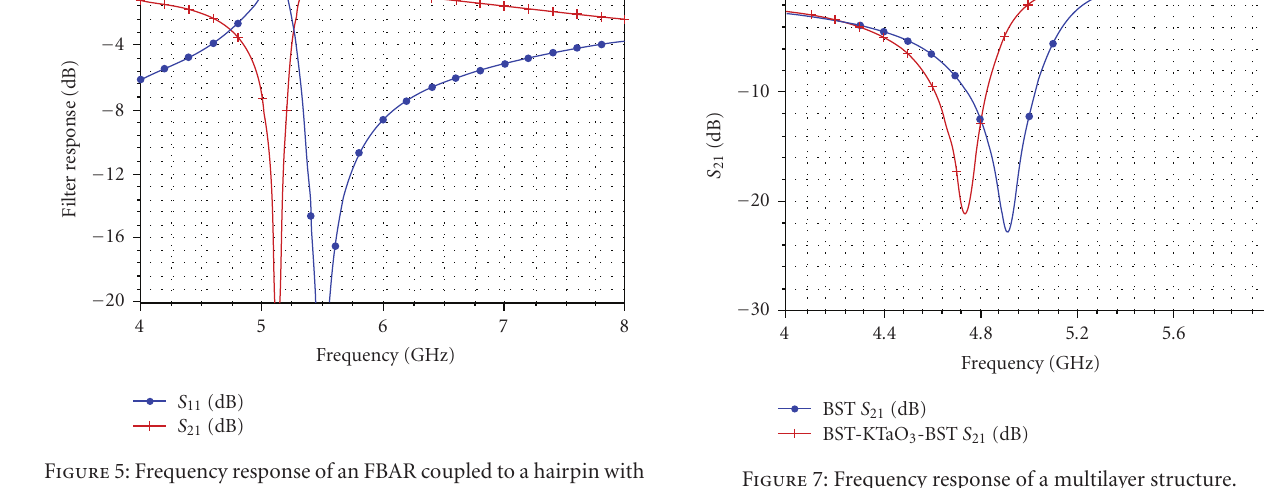
Figure 7: Frequency response of a multilayer structure.